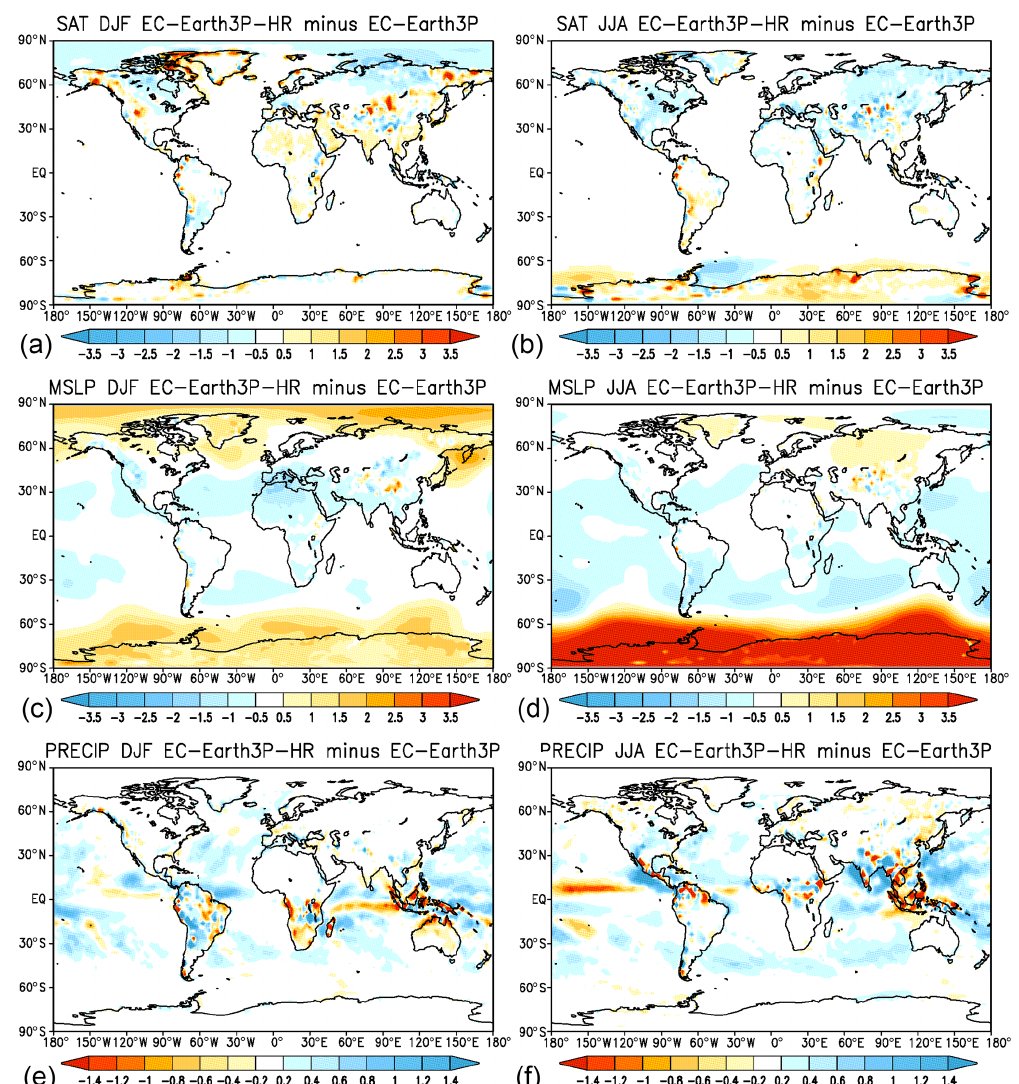
Figure 10. Differences between EC-Earth3P-HR and EC-Earth3P for SAT ( ◦ C) (a, b) , MSLP (hPa) (c, d) and precipitation (mmd − 1 ) (e, f) for DJF (a, c, e) and JJA (b, d, f)